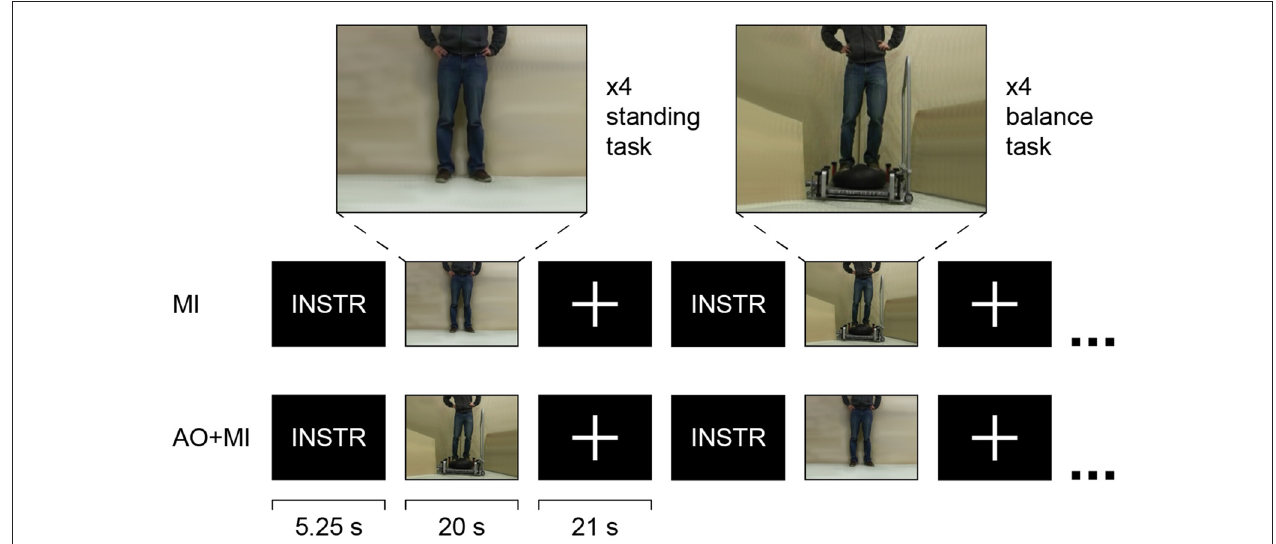
FIGURE 1 | Block-design of the fMRI experiment. Participants mentally simulated a dynamic balance task (compensating a medio-lateral perturbation) and a control task (standing still on solid ground) in two conditions: motor imagery alone (MI) and while watching a video of a person performing the task (AO+MI). In each condition, four 20-s blocks of each task, separated by 21 s of rest and 5.25 s of instruction about the next block, were performed in a randomized order. In the dynamic balance task blocks, the 20 s were composed of 10 2-s sequences where each sequence represented a perturbation.